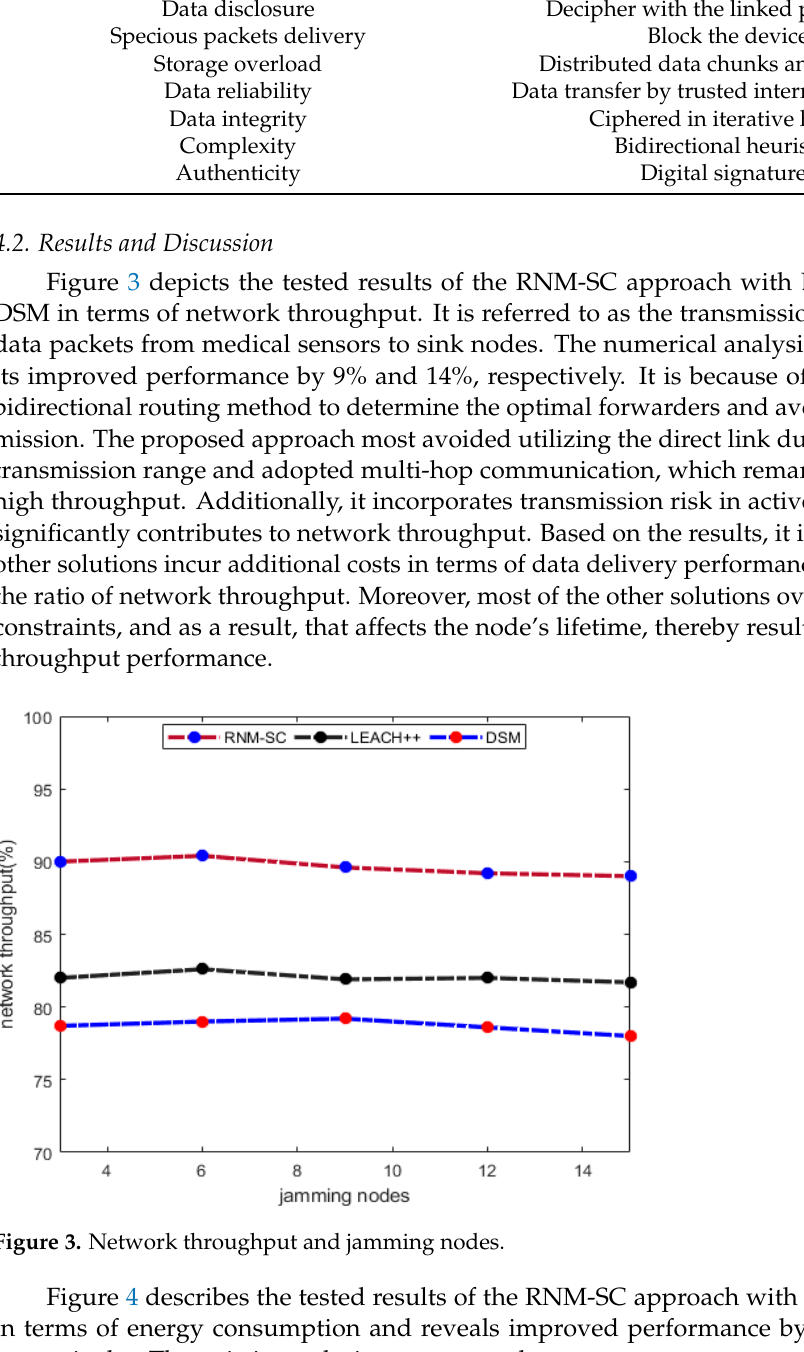
Table 2. Security analysis of our proposed approach.